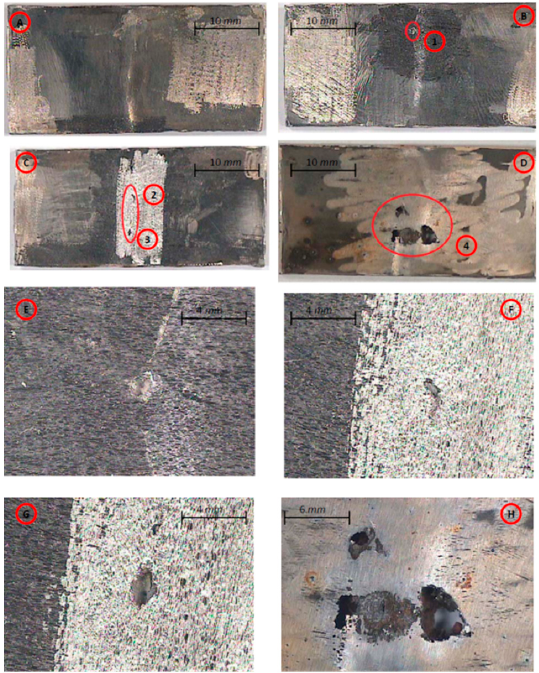
Figure 5. Pitting corrosion test of 304 stainless steel with 316L filler specimens welded in conventional atmosphere: ( A ) not-irradiated condition; ( B ) exposed to 200 Gy; ( C ) to 700 Gy; ( D ) to 1000 Gy; ( E ) defect 1 amplification from ( B ); ( F ) defect 2 amplification from ( C ); ( G ) defect 3 amplification from ( C ); ( H ) defect 4 amplification from ( D